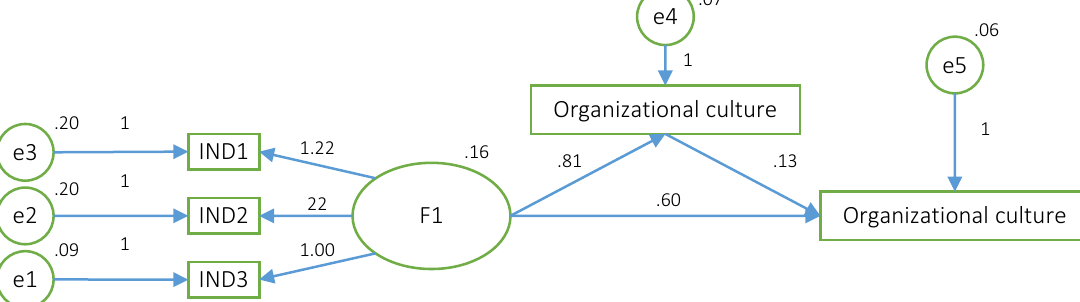
Figure 2. Path analysis